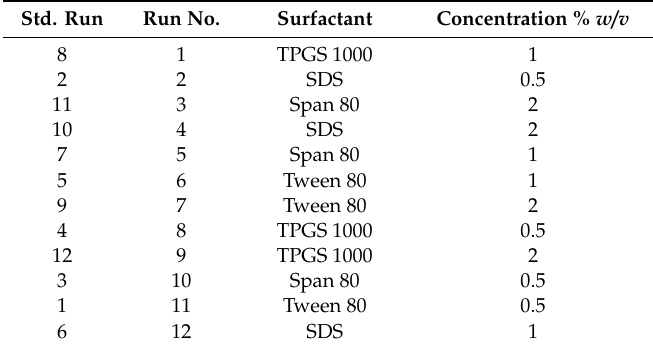
Table 1. Summary of general factorial